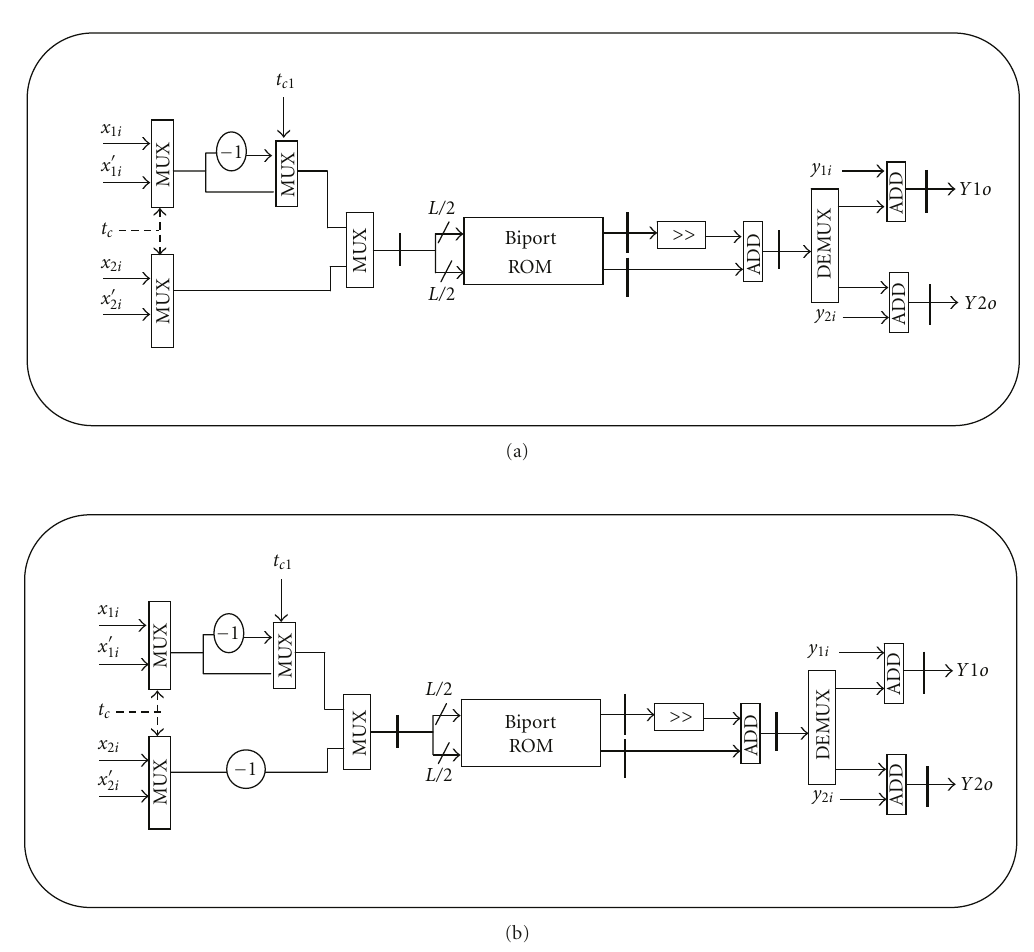
Figure 2: The structure of the first processing element PE in Figure 1. The structure of the other processing elements PE in Figure